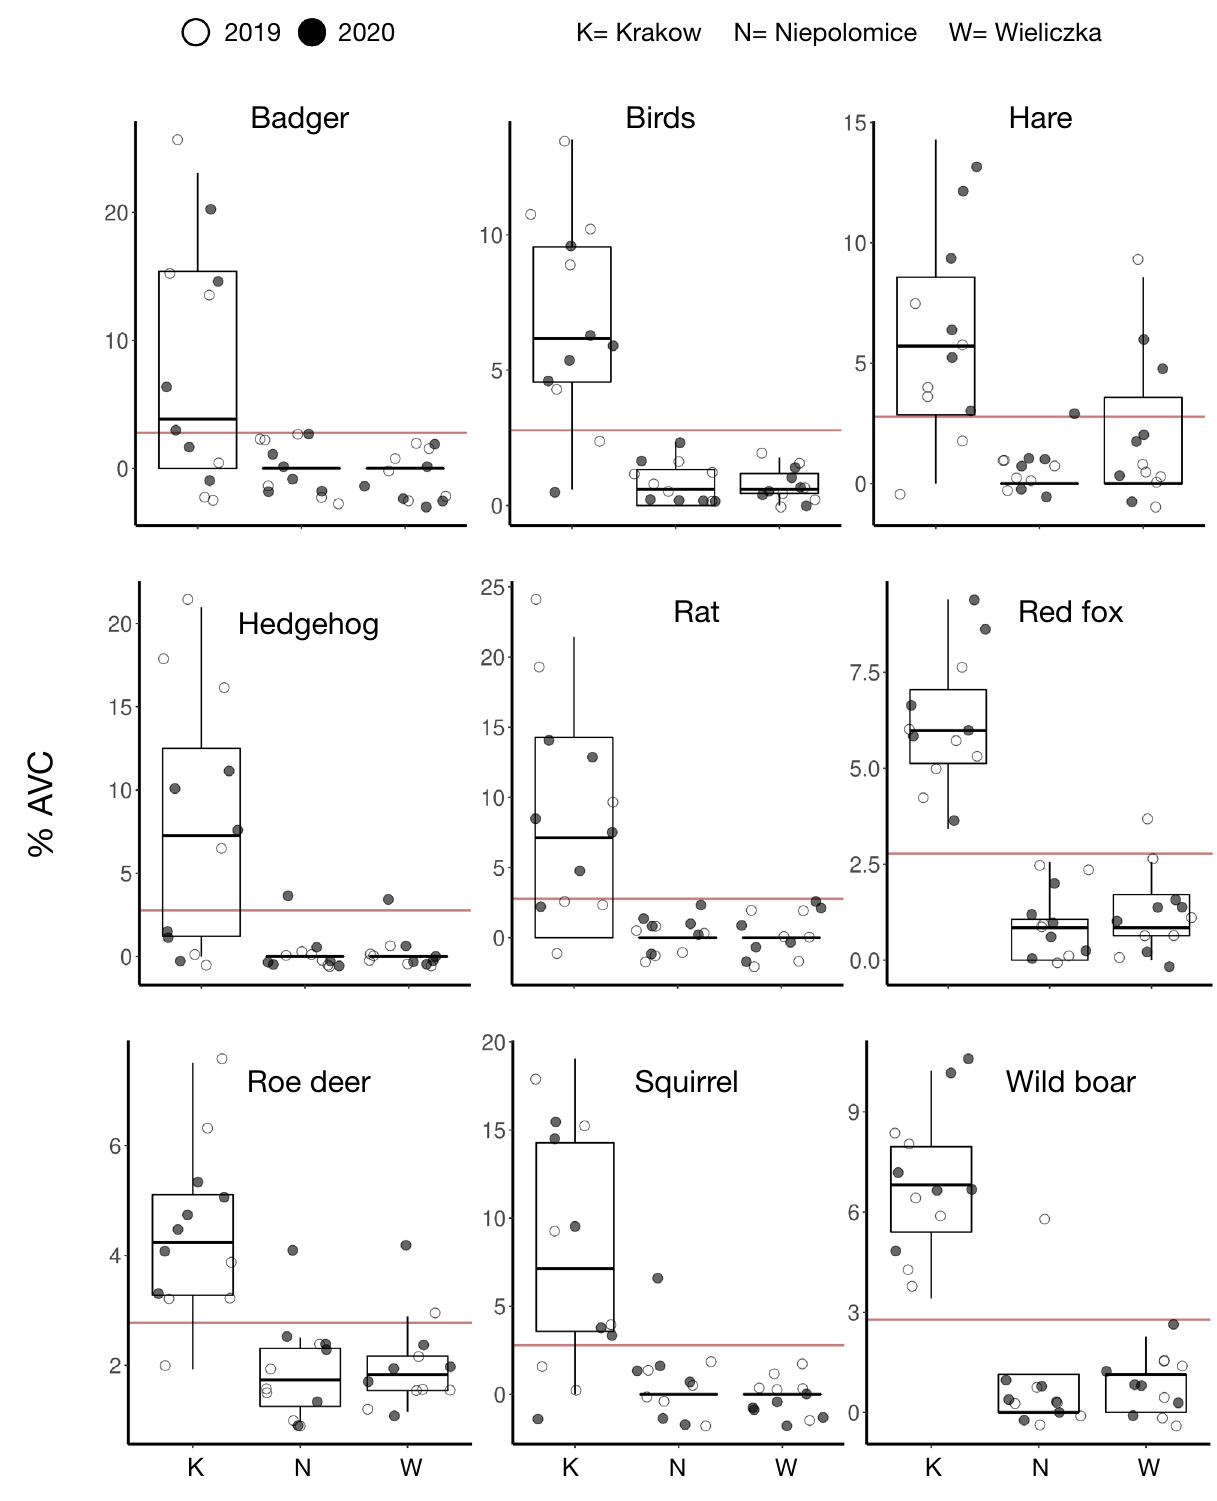
Figure 2. Distribution of AVC (y-axis) of the species with significant difference between the urban and suburban locations over the years (shape fill). The boxes represent the 25th, 50th (median) and 75th percentiles of the data; the whiskers represent the lowest (or highest) datum within 1.5 × interquartile range from the 25th (or 75th) percentile. The horizontal red line indicates the overall mean % of AVC of the specific